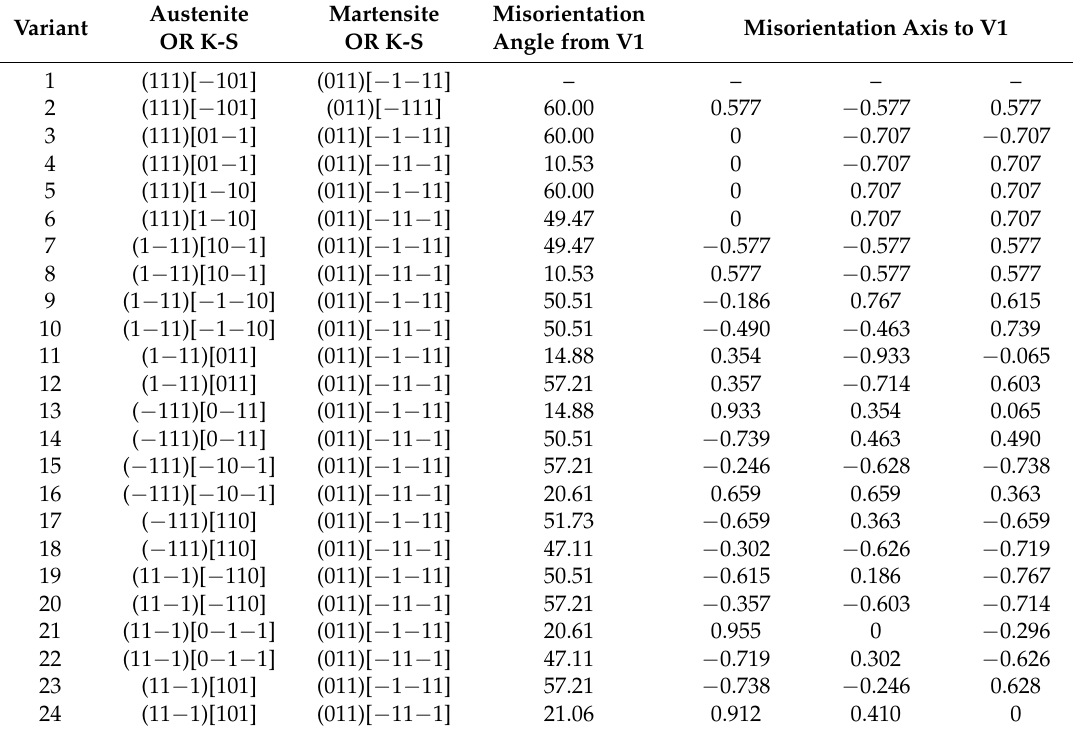
Table 2. Crystal orientations of 24 variants from the Kurdjumov-Sachs orientation relationship and crystallographic angle/axis relationships between V1 and other